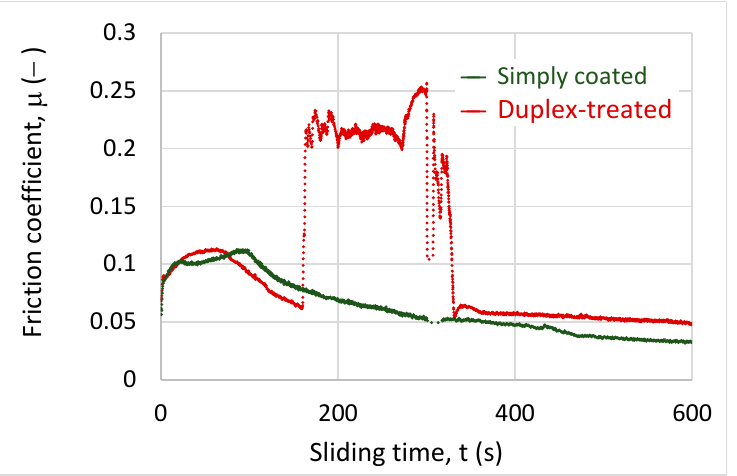
Figure 9. The initial part of the friction coefficient vs. time diagram illustrating the different wear behaviour of the DLC coating on the simple- (S) and duplex-treated substrate.